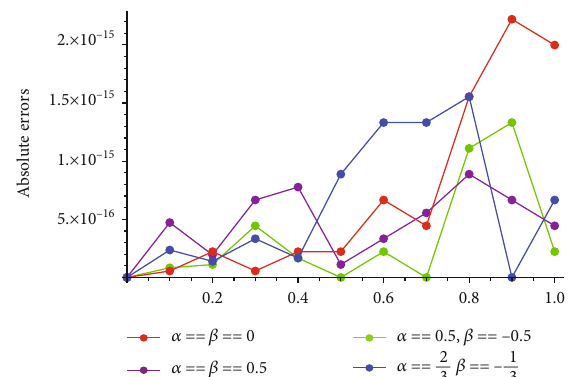
1 obtained by the present method for